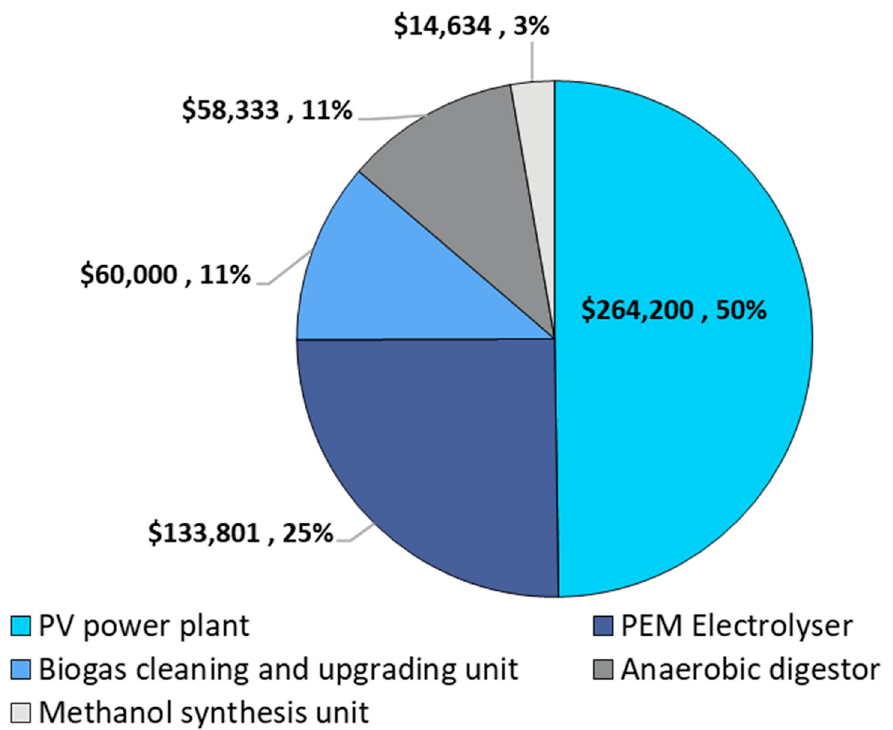
Figure 4. Breakdown and percentage distribution of the purchased equipment cost of the hybrid methanol–methane production plant. Table 5. Summary of annual cash